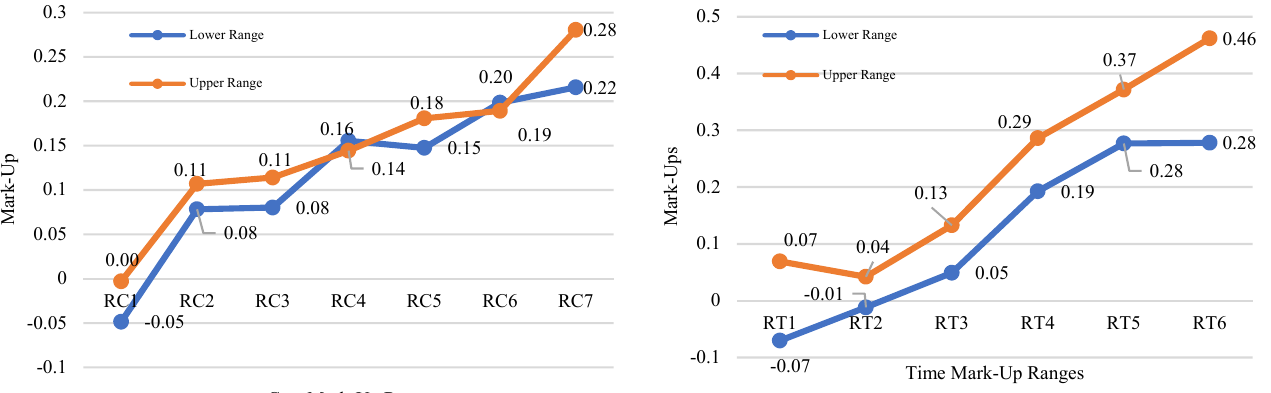
Figure 5. The no-bid area based on the analyzed data.